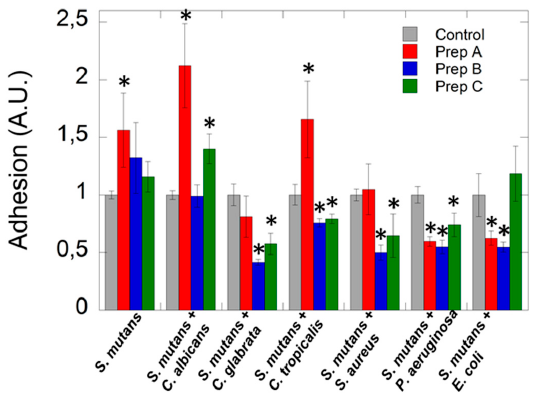
Figure 5. The impact of commercially available artificial saliva preparations on microorganism adhesion. The graph compared the abilities of tested microorganisms to adhere to wells of polystyrene microtiter plates in the presence of artificial saliva preparations using an adhesion assay that based on CV-staining method.